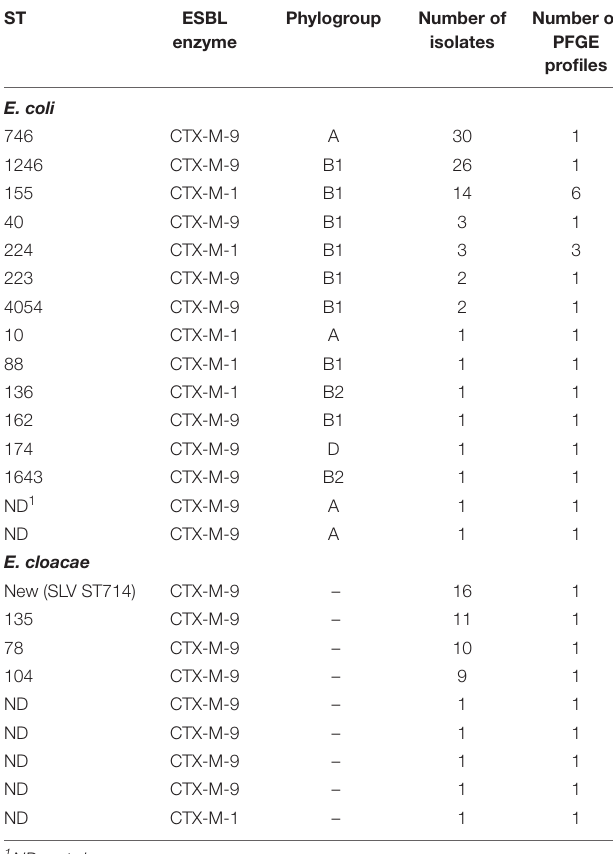
TABLE 2 | Sequence types (ST) of ESBL-producing E. coli and E. cloacae . ST ESBL